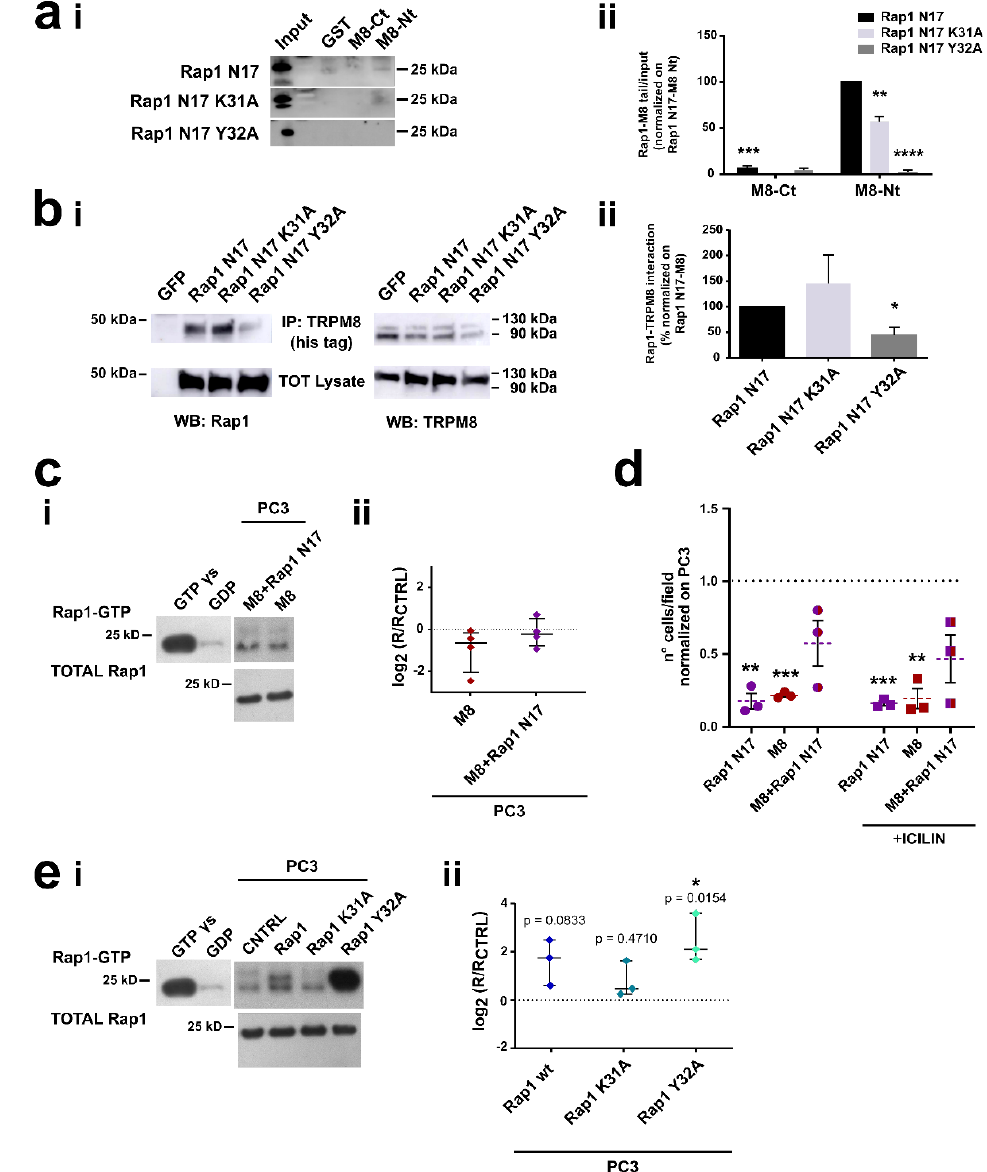
Figure 5. Rap1 mutants’ characterization. ( ai ) GST pull-down assay on TRPM8 N-terminal tail (M8-Nt), C-terminal tail (M8-Ct), or GST incubated with in vitro translated Rap1 N17, GFP-Rap1 N17 K31A and GFP-Rap1 N17 Y32A. 10% of the in vitro translated Rap1 N17 and mutants were used for the input of the GST pull-down. Western blotting was performed with an anti-Rap1 antibody and one representative experiment of three is shown. ( aii ) Quantification of Rap1-TRPM8 tails interaction normalized on the input. Values are normalized on Rap1 N17-M8Nt ratio and data are expressed as mean ± SEM. Statistical significance versus Rap1 N17 -TRPM8 Nt: **: p < 0.01; ***: p < 0.001; ****: p < 0.0001 (Two- way ANOVA with Tukey’s HSD post-hoc test). ( bi ) Representative immunoprecipitation experiment. PC3M8 cells were transfected with GFP-Rap1 N17, GFP-Rap1 N17 K31A and GFP-Rap1 N17 Y32A plasmids. Cell lysates were immunoprecipitated (IP) for TRPM8 and immunoblotted with anti-GFP antibody for Rap1 detection (panels on the left) and anti-myc antibody for TRPM8 detection (panels on the right). ( bii ) Quantification of Co-IP experiments on TRPM8 and Rap1 mutants. Data are normalized on TRPM8-Rap N17 interaction and they are expressed as mean ± SEM ( n = 4). Statistical significance versus TRPM8-Rap1 N17, * = p < 0.05 (Student t-test). ( ci ) Active Rap1 pull-down assay on PC3 stably overexpressing TRPM8 transfected with Rap1 mutants ( 8 μg ). ( cii ) Quantification of the active Rap1 as the ratio between Rap1-GTP over total Rap1 (R) normalized on this ratio on PC3 (R CTRL ). Data are expressed as log 2 and shown in a